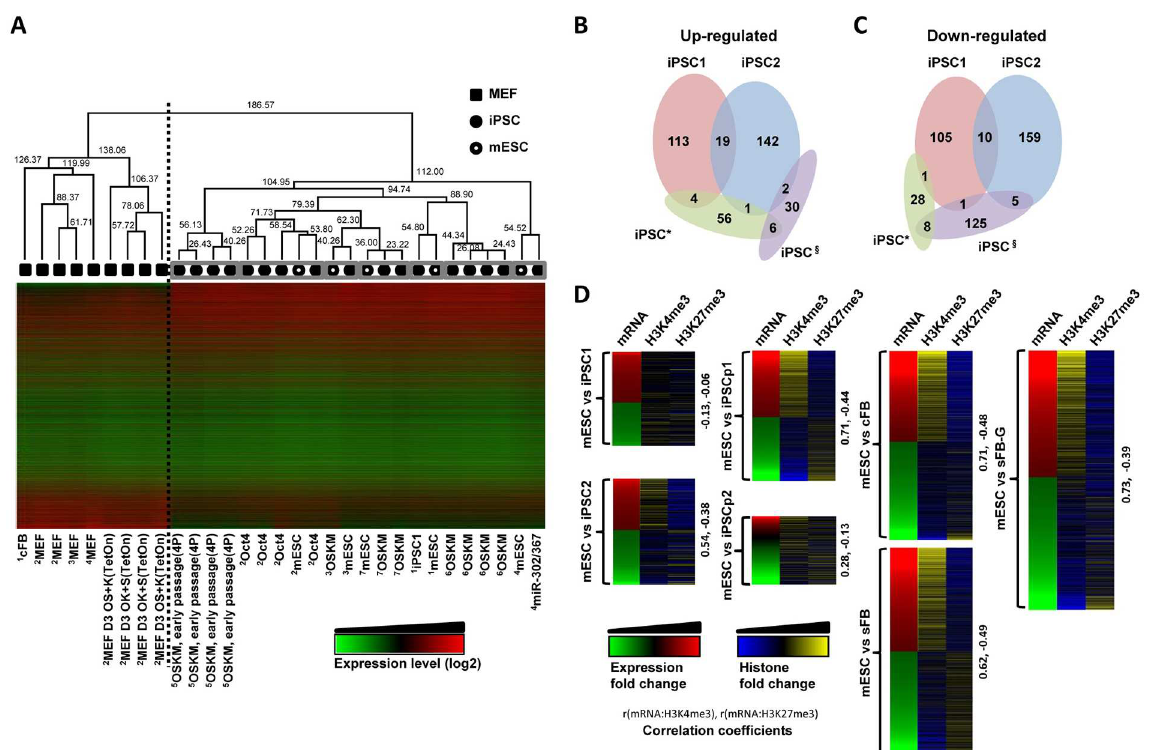
Fig 3. Comparative analysis of the protein-based iPSCs and other pluripotent cells. (A) Hierarchical clusteringof the gene expressionmicroarray data for the mESCs (open circles), iPSCs (filled circles), and fibroblasts(filled squares) from different laboratories. The data sets of the mESCs and iPSCs obtainedfrom the same laboratory are marked using grey boxes. The iPSC inductionmethods are labelledfor each iPSC data set: 1 GSE13770, 2 GSE24930, 3 GSE17004, 4 GSE27814, 5 GSE22908, 6 GSE24046, and 7 GSE27087. (B-C) The Venn diagramshows the overlapof the differentiallyexpressed genes betweenmESCs and iPSCs. For comparison, two iPSC * (GSE24046)and iPSC § (GSE27814) data sets are also incorporated. (D) The gene expression levels and histonemodifications of the differentiallyexpressedgenesdefinedin (B-C) are shown and the Pearson correlation coefficients are presentedon the right side of each